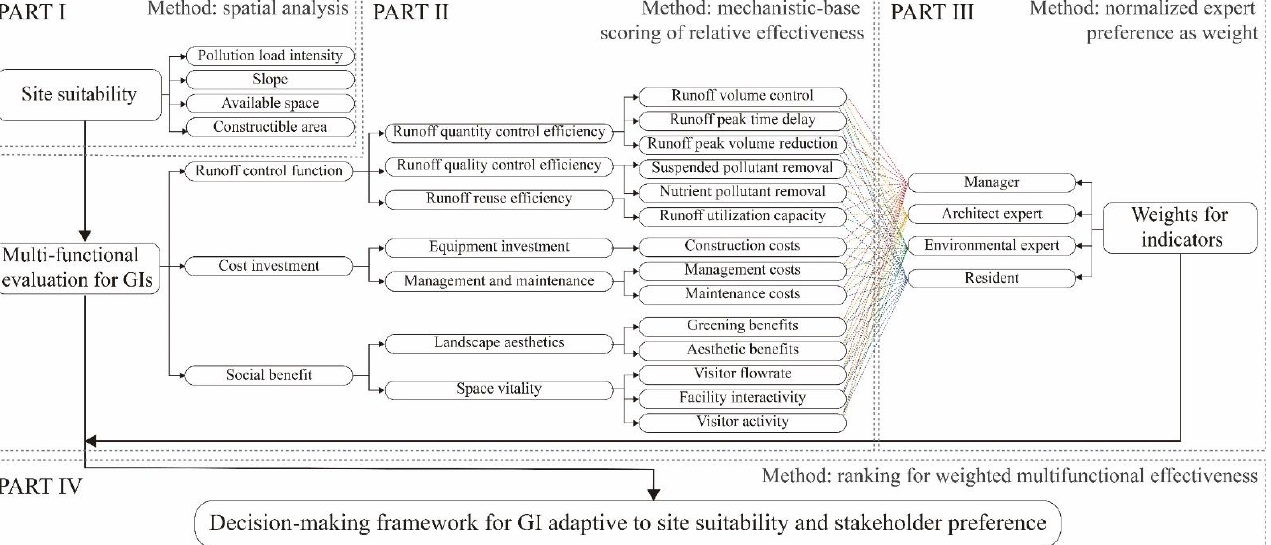
Figure 2. Methodological